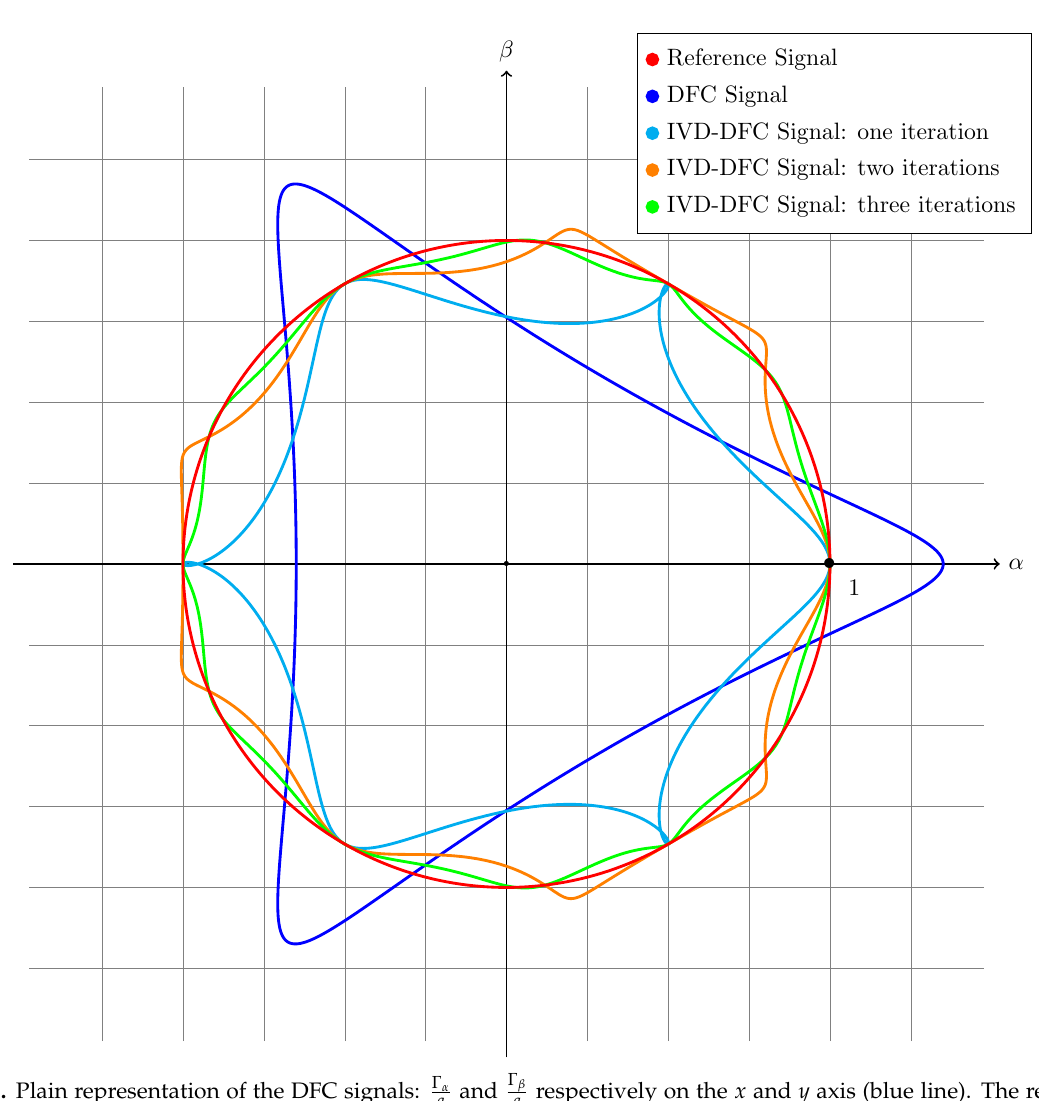
Γ Γ β and respectively on the x and y axis (blue line). The red circle α a a